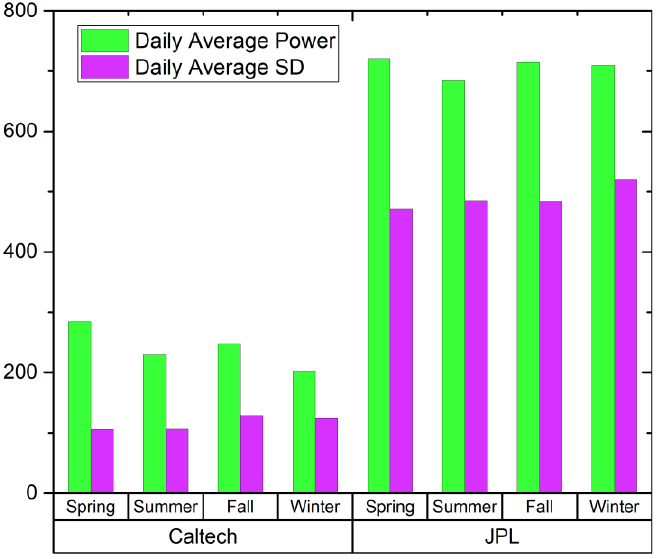
Figure 2. Seasonal variation of power demand.